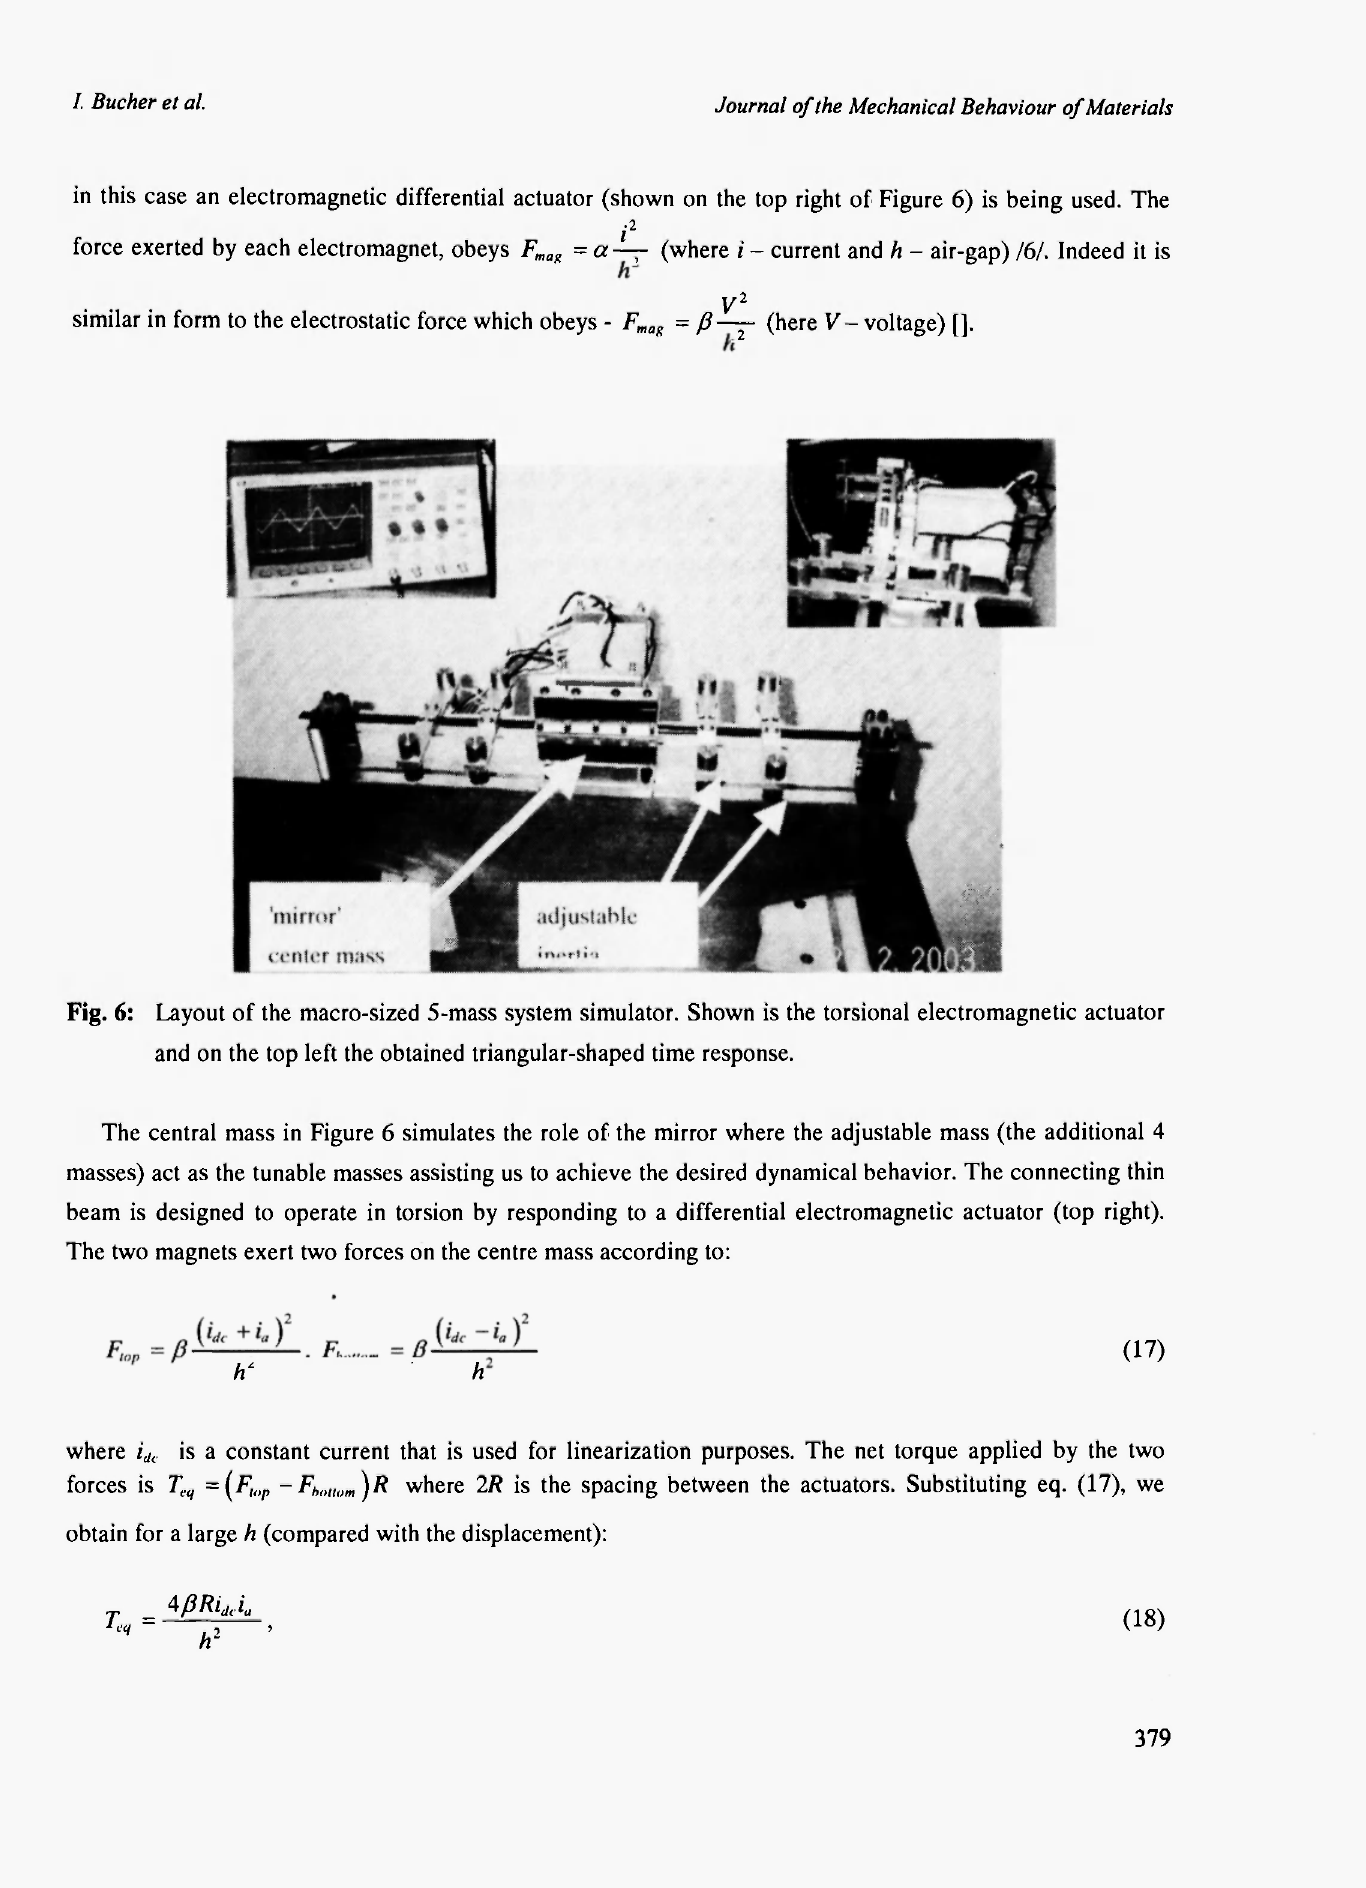
Fig. 6: Layout of the macro-sized 5-mass system simulator. Shown is the torsional electromagnetic actuator and on the top left the obtained triangular-shaped time response.